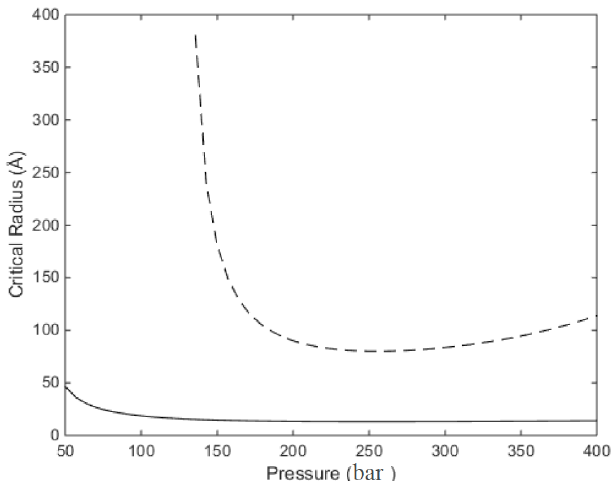
Figure 11. Calculated critical radius for heterogeneous nucleation of hydrate from CO 2 and liquid water as a function of pressure for 280 K (solid) and 285 K (dashed).